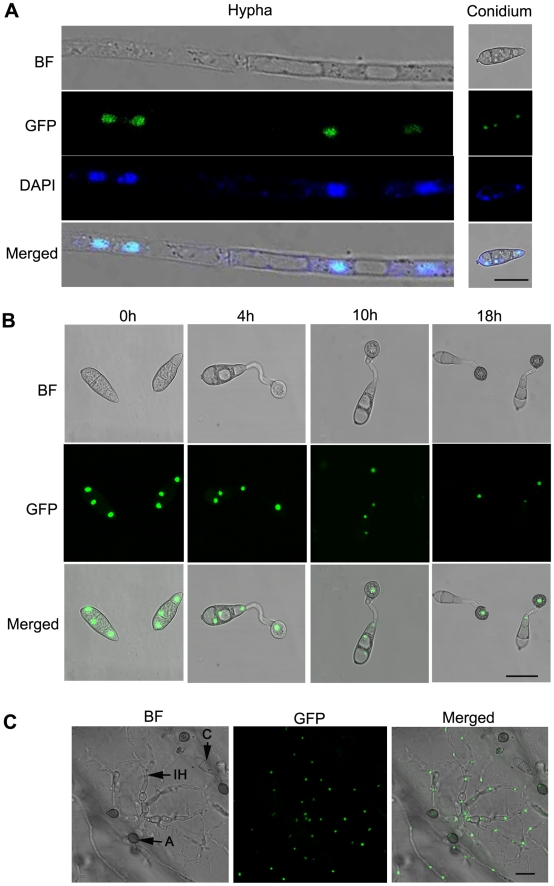
Intracellular localization of MoSom1-green fluorescent protein.(A) MoSom1 was localized to the nucleus. MoSom1 C-terminal green fluorescent protein (GFP) fusion strategy was conducted to generate GFP expression transformants. One of the transformants, SC3, was used for MoSom1 localization assay. Conidia and mycelia of SC3 were stained by DAPI (4′-6-Diamidino-2-phenylinodle). The merged image of GFP and DAPI staining showed that MoSom1-GFP localized in the nucleus. (B) The patterns of MoSOM1 expression and nuclear division during appressorium development. Conidia of the strain SC3 was allowed to germinate on hydrophobic GelBond film surfaces. Photographs were taken at various time intervals. (C) Expression of MoSOM1 during invasive growth. The assay was performed by placing 30 µl conidial suspension of SC3 on onion epidermis. Photographs were taken at 48 h after incubation. Arrows indicate conidium, appressorium or invasive hypha inside cells. C = conidium; A = appressorium; IH = invasive hypha. BF = bright field. All of bars = 10 µm.